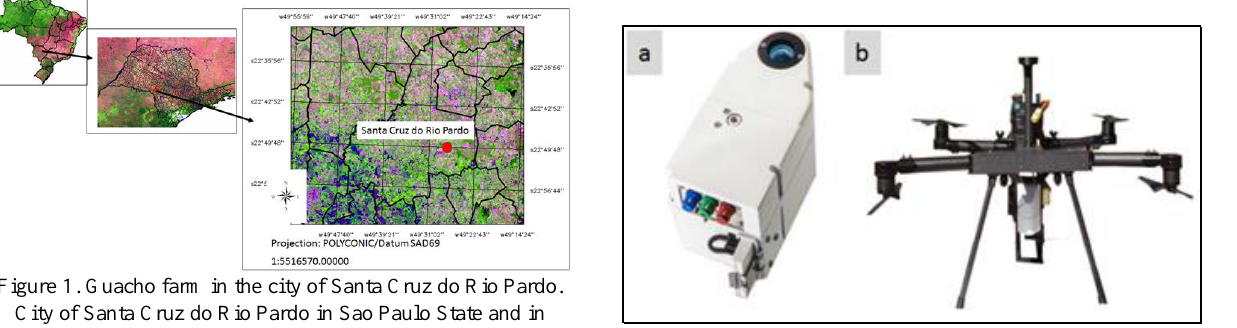
Figure 3. a) Rikola Hyperspectral Camera; b) quadcopter